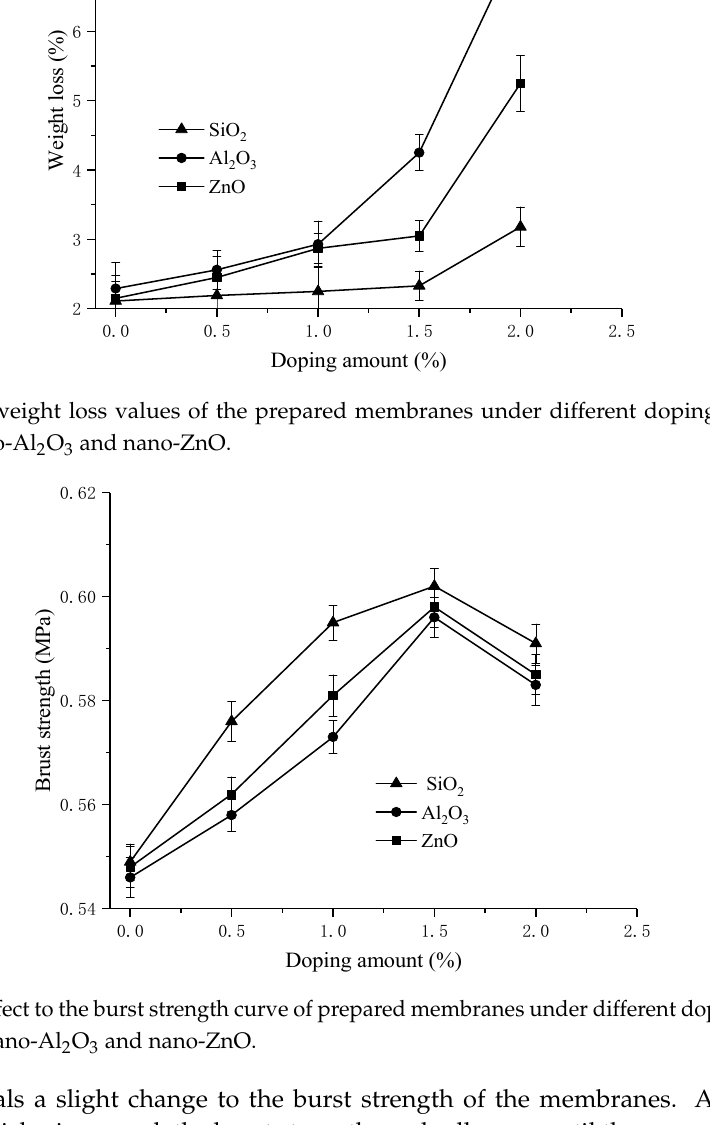
Figure 7. The weight loss values of the prepared membranes under different doping amounts of nano- SiO 2 , nano-Al 2 O 3 and nano-ZnO.